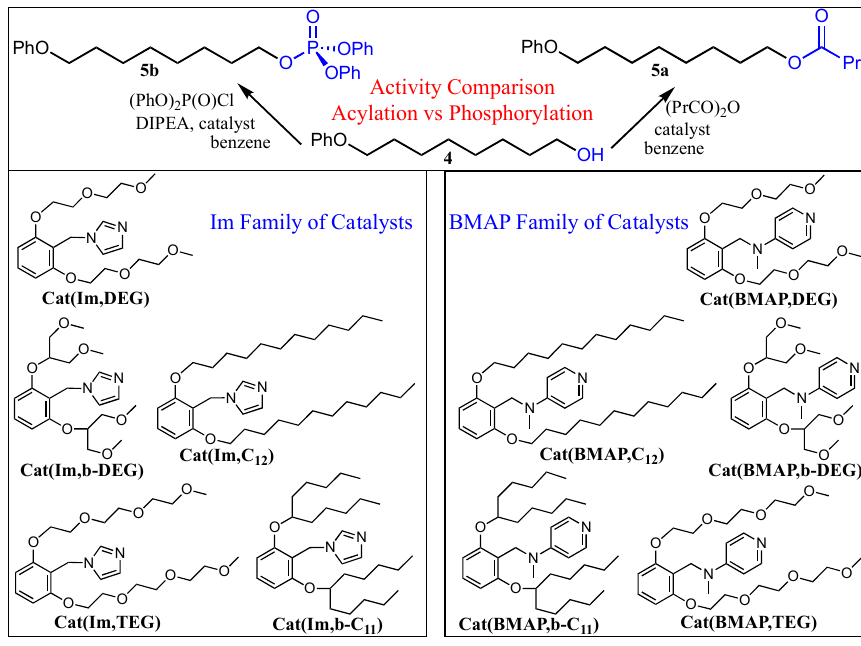
Scheme 2. The activity comparison with model substrate 4 .